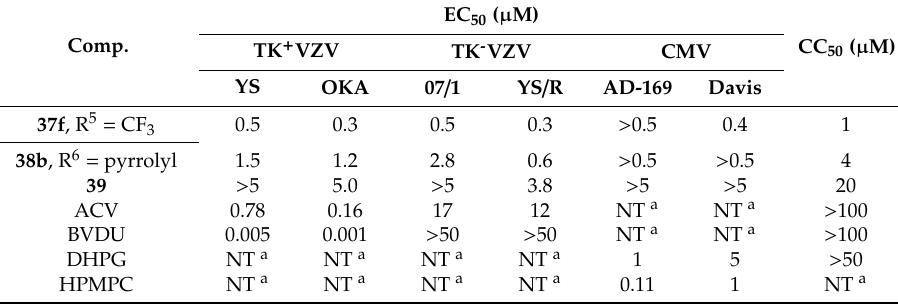
Table 14. The antiviral activities of the pyrimidine and purine L -ASA derivatives. Comp.